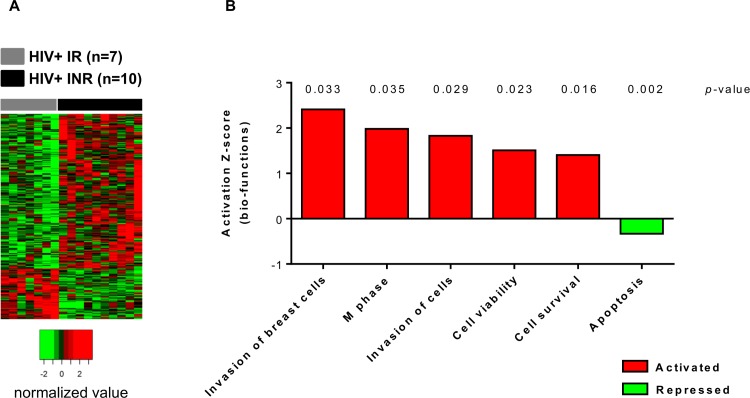
Transcriptomic analysis of CD34+ cells in HIV-infected IRs and INRs.(A) Genes differentially expressed in the CD34+ cells of IRs (n = 7) and INRs (n = 10) are shown. Each column represents an individual sample, and each row, an individual gene, with normalized expression level indicated on a color scale (red = upregulation, green = downregulation). (B) The top 5 biological functions in Ingenuity analysis, based on activation z-score, an algorithm predicting the degree of activation or inactivation of the genes of the group concerned. Rank in the top 5 is indicated by the number after the #. P-values are shown. Biological functions upregulated (positive z-score) in IR patients are shown in red, and biological functions downregulated in IR patients (negative z-score) are shown in green.